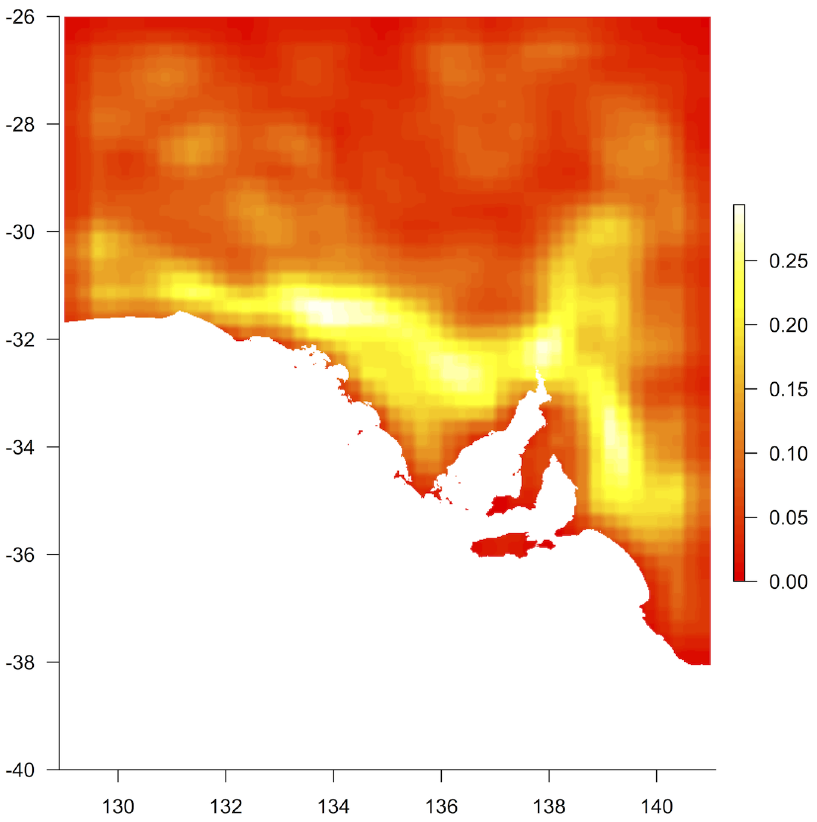
Fig 3. Beta diversity. Here beta diversity is represented by the mean change in a Canonical Correspondence Analysis axis coordinate within a moving window of 3 x 3 grid cells, when this axis is constrained by ‘ mean maximum temperature of the hottest month ’ (combined data). Higher values represent more rapid turnover along the compositional